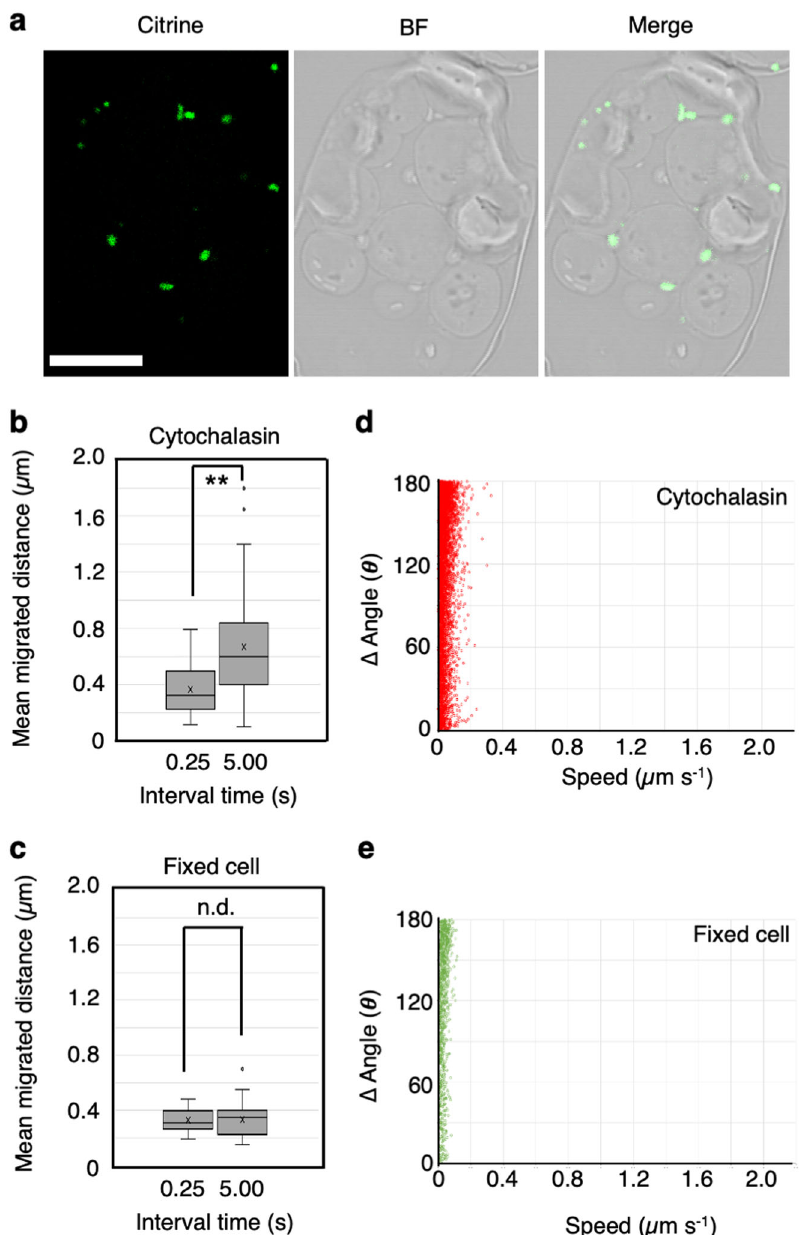
Fig. 6 Mitochondrial movement in cytochalasin-treated protoplasts is different from that in fi xed cells. a CLSM images of mitochondria (Citrine, green) and bright fi eld (BF) images of fi xed cells were merged (Merge). Scale bar: 10 µ m. b , c Mean migration distance of mitochondria in cytochalasin-treated protoplasts ( b ) and in fi xed cells ( c ) from time-lapse videos taken at 0.25-s and 5-s intervals. The values represent the mean ± S.D. in b and c . ** P < 0.01, n.d. P > 0.05 (Student ’ s t test). N.d. no difference. d , e Scatter plot of speed ( x -axis) and angle changes ( y -axis) of mitochondria at each time point acquired from the trajectories of mitochondrial movements in three fi xed protoplasts. Each plot is shown as cytochalasin-treated ( d ) and fi xed (green) protoplasts ( e